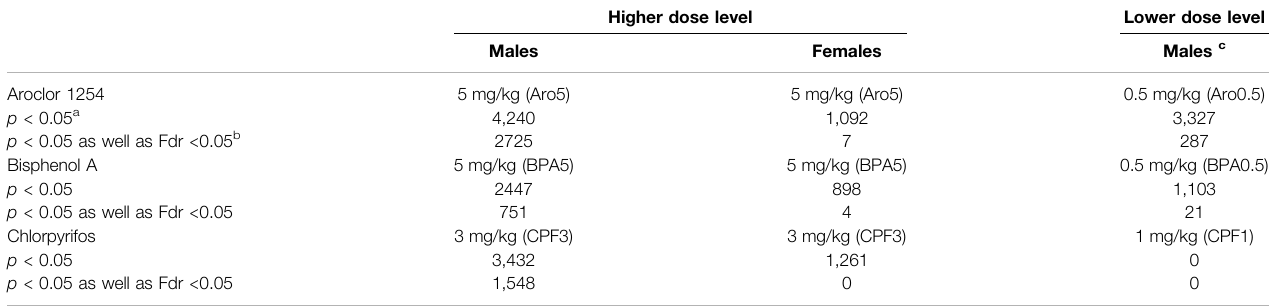
TABLE 2 | Number of genes with signi fi cant change of expression rate in transcriptomics analyses of rat hippocampus at postnatal day 6, according to p value and false discovery rate (Fdr).